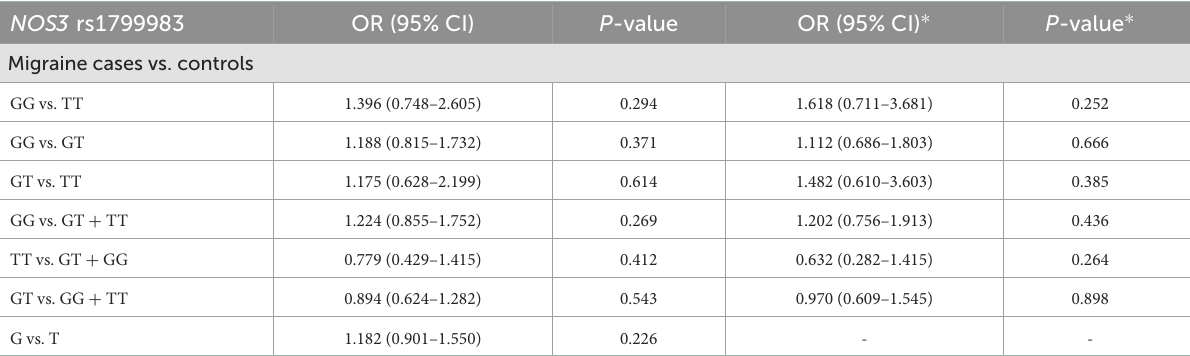
TABLE 4 Genotypic and allelic frequency distribution analysis of the NOS3 rs1799983 variant between migraine cases and control subjects. NOS3